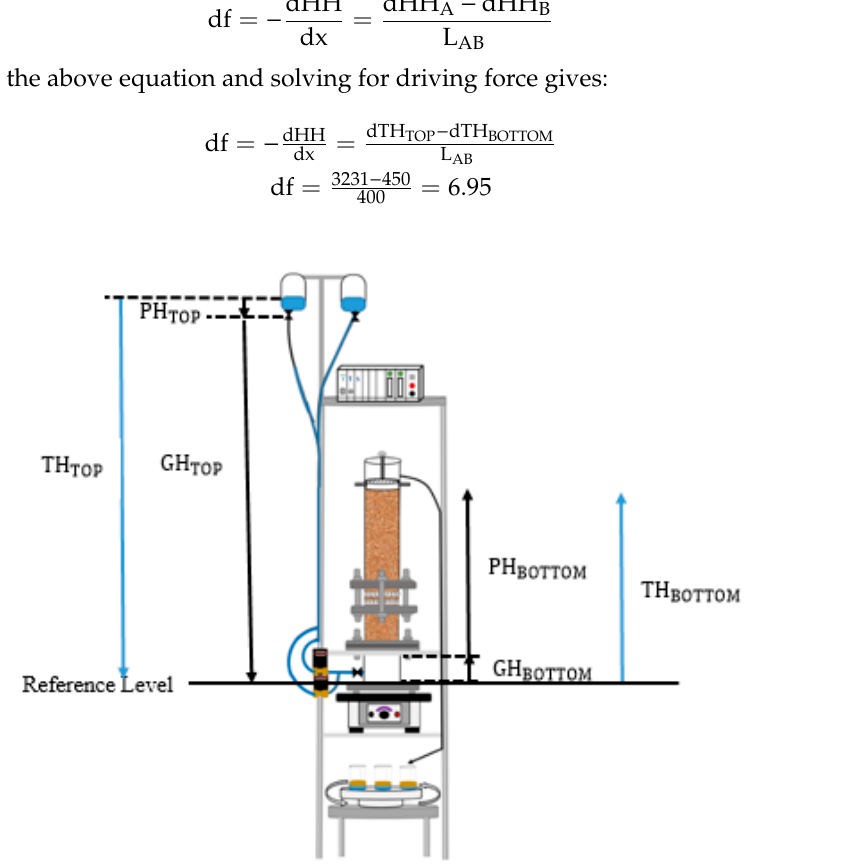
Figure 2. A model to explain fluid flow from gravity drainage system through the sand-pack taking into account the total heads at the top and bottom of the system. Where TH represents the total head and is the summation of GH, the gravitational head and PH, the pressure head.